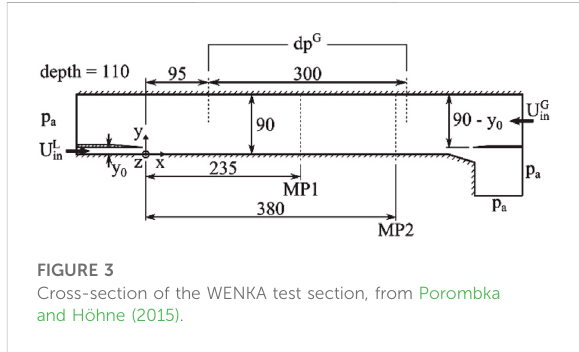
FIGURE 3 Cross-section of the WENKA test section, from Porombka and Höhne (2015).